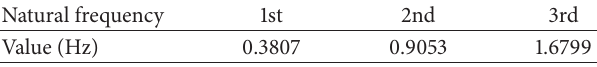
Table 1: The natural frequencies of the boom system.